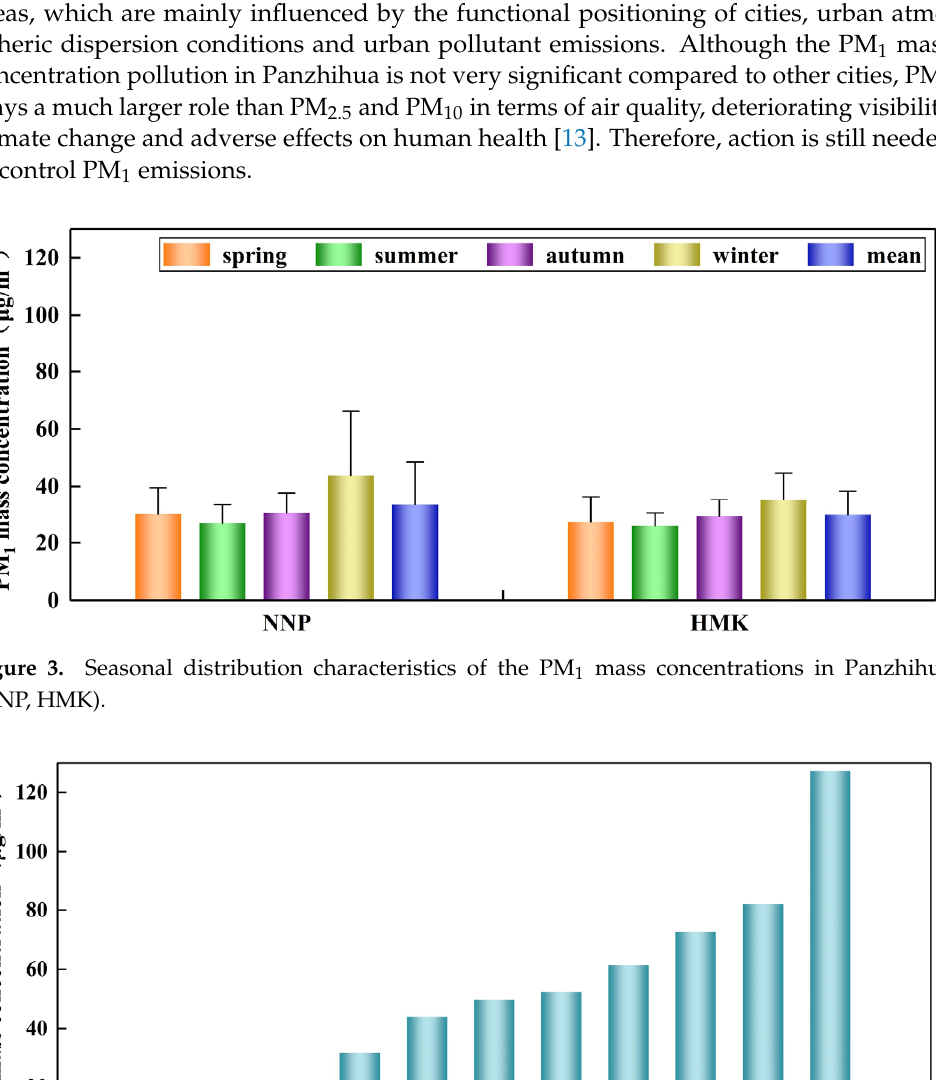
Figure 4. Annual average mass concentration of PM 1 in different cities. ELX: Elche, Spain [29]; BHM: Birmingham, UK [56]; AUT: Austria [57]; KRA: Krakow, Poland [58]; PZH: Panzhihua, China (This